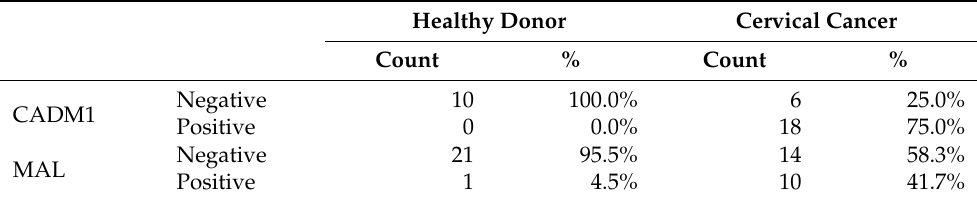
Table 2. CADM1 and MAL methylation status in blood samples from healthy donors and cervical cancer patients. Healthy Donor Cervical Cancer Count % Count Negative